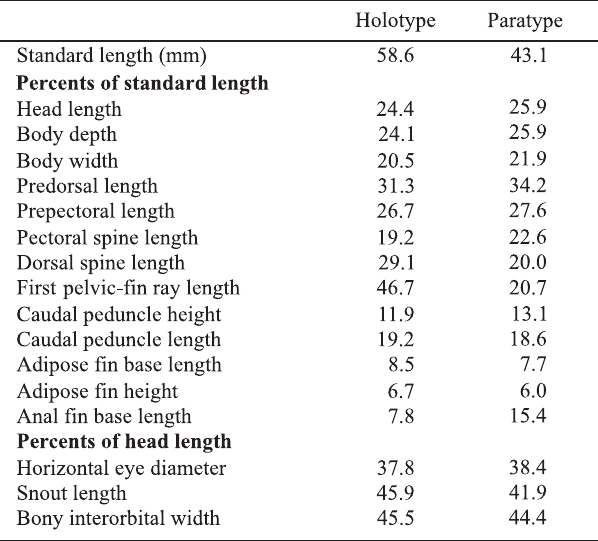
Table 1. Proportional measurements for the holotype and paratype of Entomocorus melaphareus